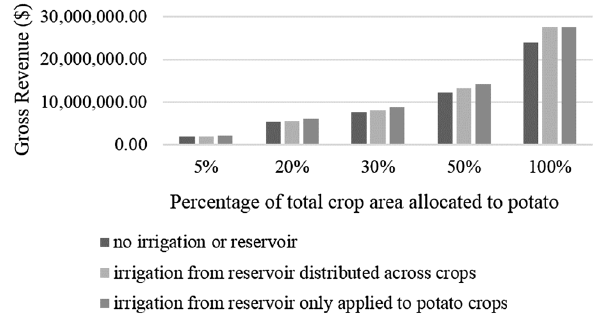
Fig. 6 Study area gross crop revenue for 2006, simulating various irrigation application scenarios, using four crops (alfalfa, canola, wheat, and potato), and adjusting the percentage of crop area allocated to potato to determine its impact on gross crop revenue